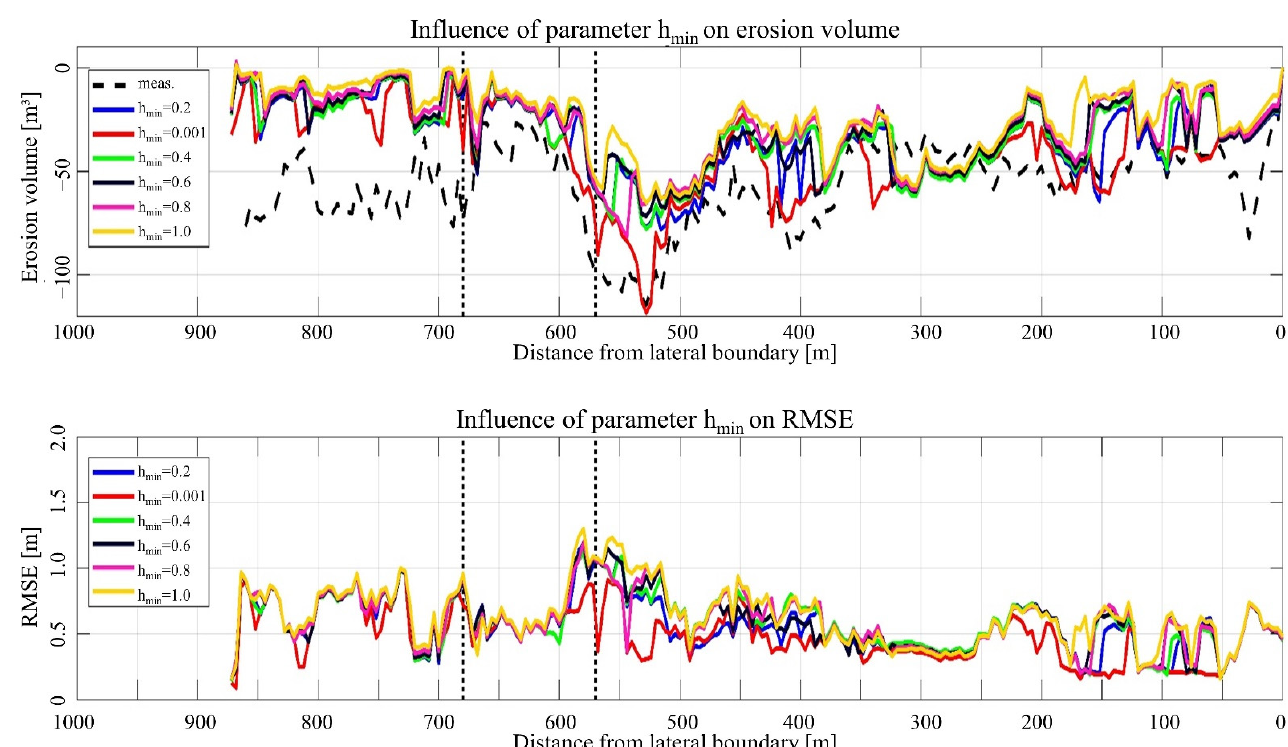
Figure 22. Influence of the parameter h min on erosion volume and statistical parameter RMSE, Hütel- moor.